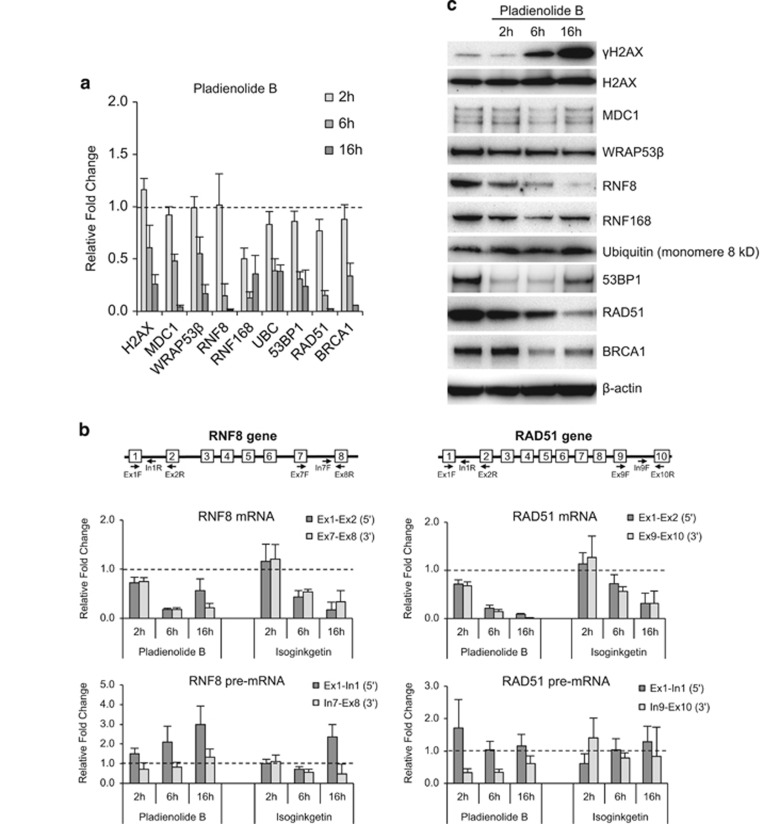
Inhibition of splicing downregulates repair factors at both the mRNA and protein levels. (a) U2OS cells were treated with pladienolide B for 2, 6 and 16 h and irradiated (6 Gy, 1 h recovery) 1 h prior to termination of the treatment. The levels of the indicated mRNAs were measured through qPCR analysis. The change is relative to the DMSO control and two reference genes (18S rRNA and β-actin). Means±S.D. are shown, n=3. (b) qPCR analysis of the levels mRNA and pre-mRNA for RNF8 and RAD51 in U2OS cells treated with pladienolide B or isoginkgetin for 2, 6 or 16 h and irradiated (6 Gy, 1 h recovery) 1 h prior to termination of this treatment. The change is expressed relative to the DMSO control value and the levels of mRNA for two reference genes (18S rRNA and β-actin). Means±S.D. are shown, n=3. The arrows indicate the positioning of the PCR primers used and their sequences are shown in Supplementary Table S1. (c) Western blotting following pladienolide B treatment of U2OS cells as described in (a). β-Actin was used as a loading control. Densitometric quantification of each protein is shown in Supplementary Figure S2B. The three MDC1 bands correspond to the unphosphorylated, phosphorylated and hyperphosphorylated forms of full-length MDC1